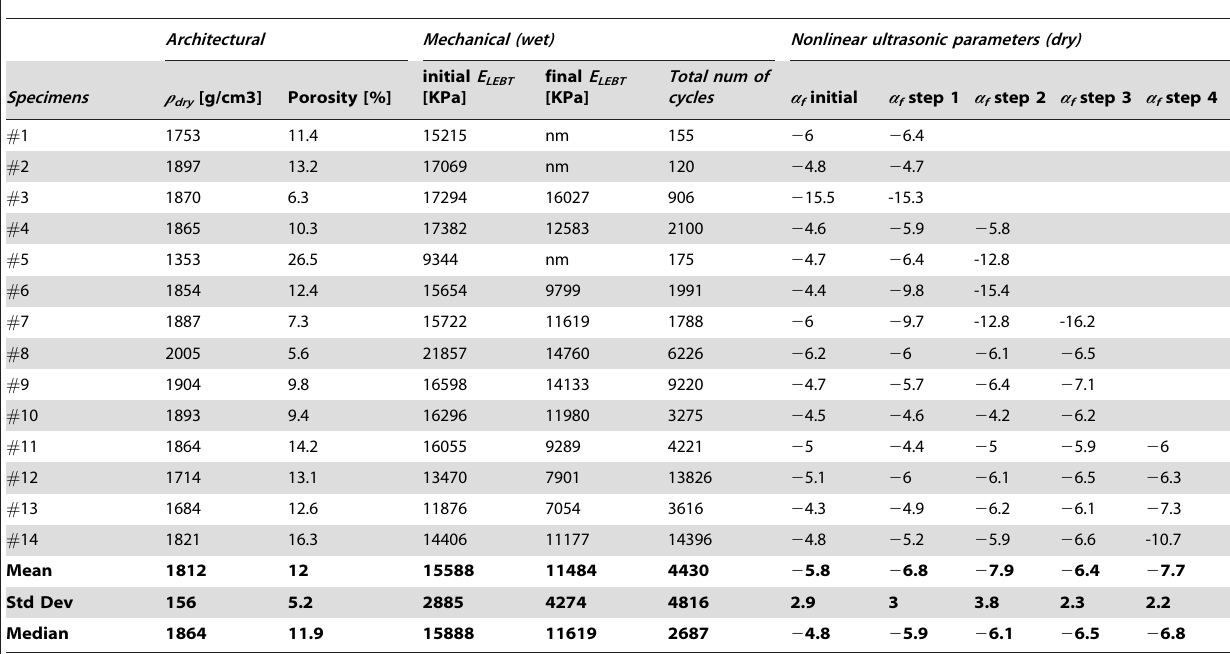
Table 1. Characteristics of the human cortical bone specimens: density ( r dry ) , initial mechanical modulus LEBT ( E LEBT ), number of damage steps, number of cycles, initial, intermediate and final nonlinear elastic parameters ( a f ).